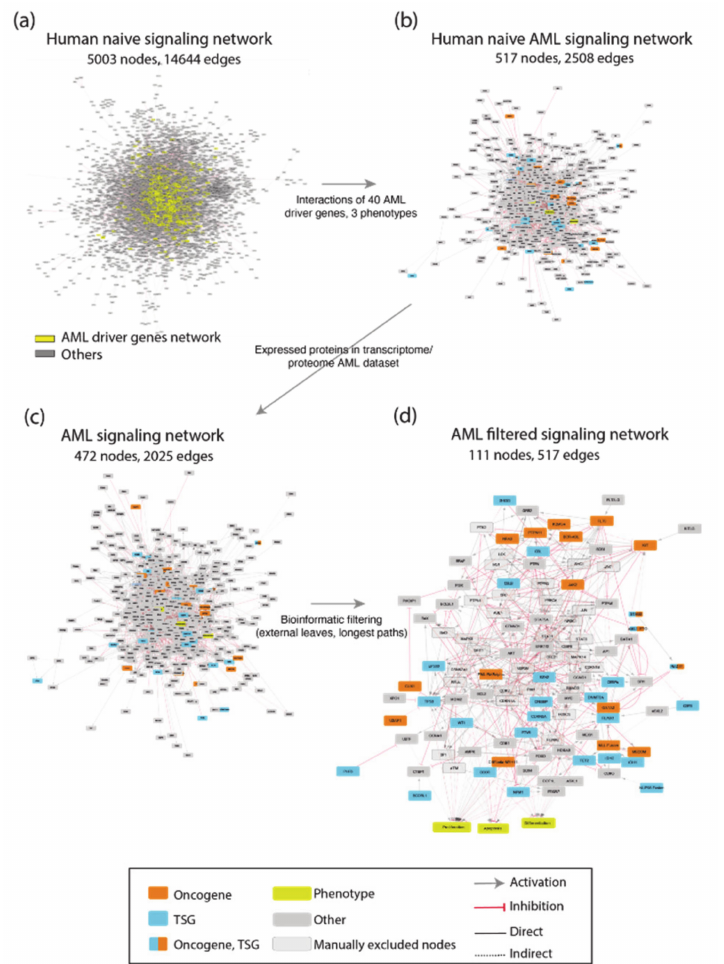
Figure A1. Network-based approach. ( a ) Human naïve signaling network, as derived from SIGNOR, was filtered to keep only the paths connecting the 40 AML driver genes to AML hallmarks ( b ). This network was filtered excluding proteins not expressed in AML ( c ) and other bioinformatic filters were applied ( d